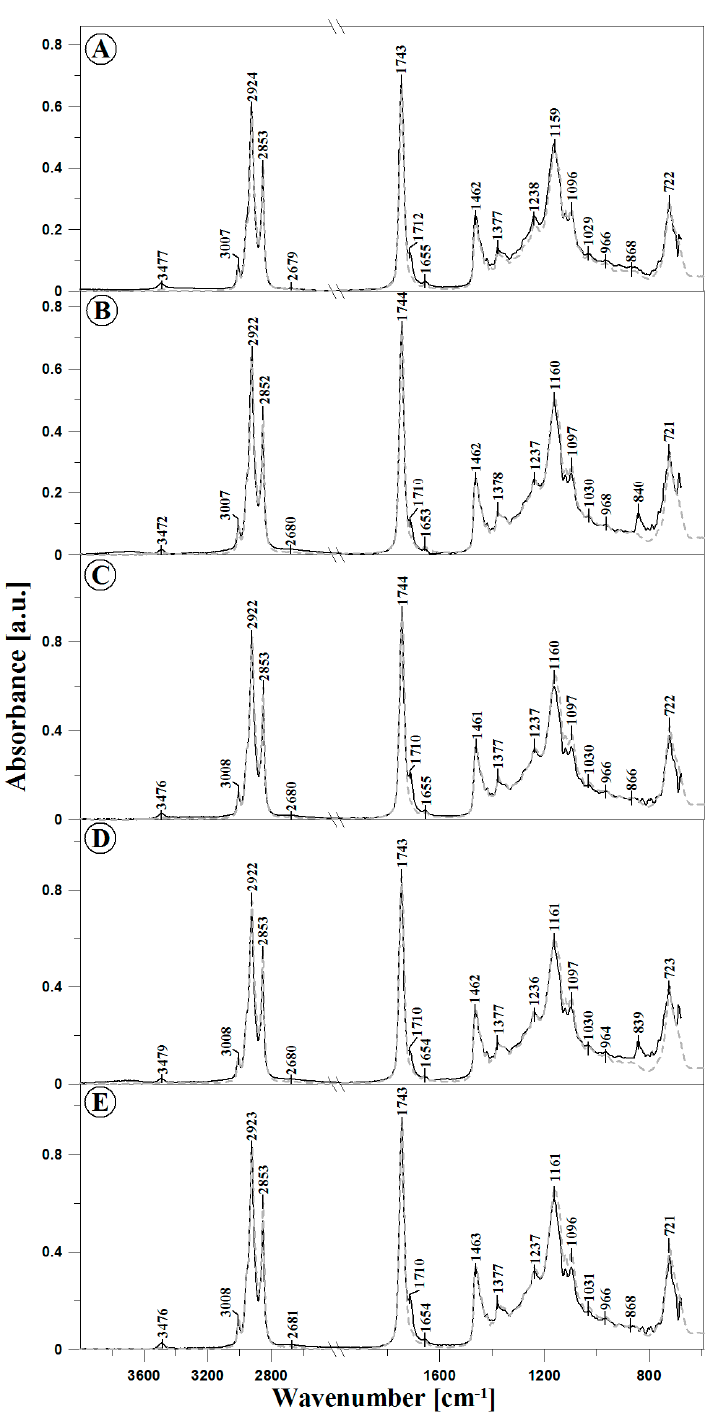
Figure 2. Exemplary ATR-FTIR spectra of the studied rapeseed oil samples from 2016 (gray broken line) and 2017 (black solid line): ( A ) control; ( B ) (O) AgNC; ( C ) (O) CuNC; ( D ) (N / O) AgNC; and ( E ) (N / O) CuNC. The spectra are presented in the spectral range of 590–4000 cm − 1 . Spectra are normalized at the intensity of a peak at 1743 cm − 1 .